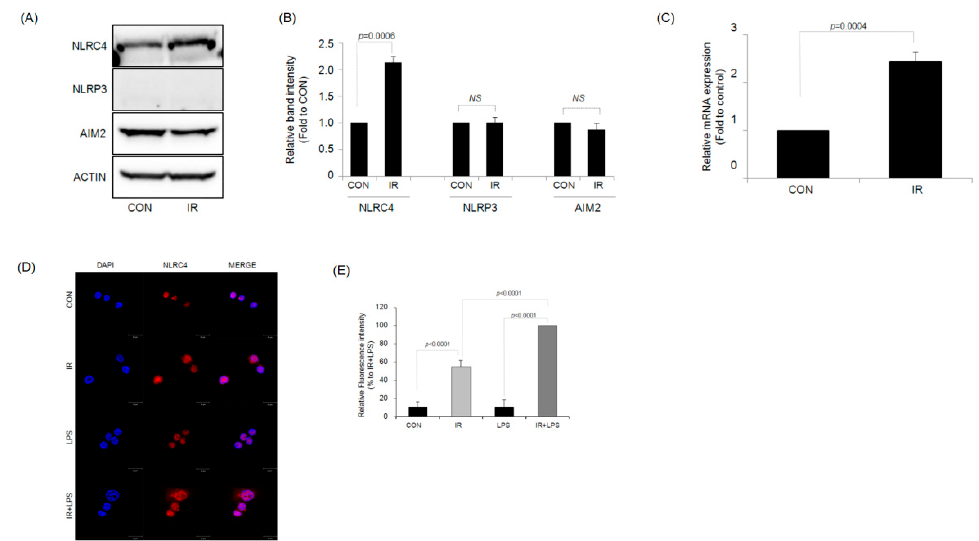
Figure 4. Ionizing radiation (IR) activates the NLRC4 inflammasome in the RAW264.7 macrophage cell line. ( A ) Representative western blotting images and ( B ) quantitative analysis of inflammasome protein levels in control and irradiated RAW264.7 macrophages. ( C ) Analysis of Nlrc4 mRNA levels by quantitative PCR in control and irradiated RAW264.7 macrophages. ( D , E ) Fluorescence images of RAW264.7 cells after staining with NLRC4; red (PE) indicates NLRC4, and blue (DAPI) indicates the nuclei. Scale bar = 20 μ m.